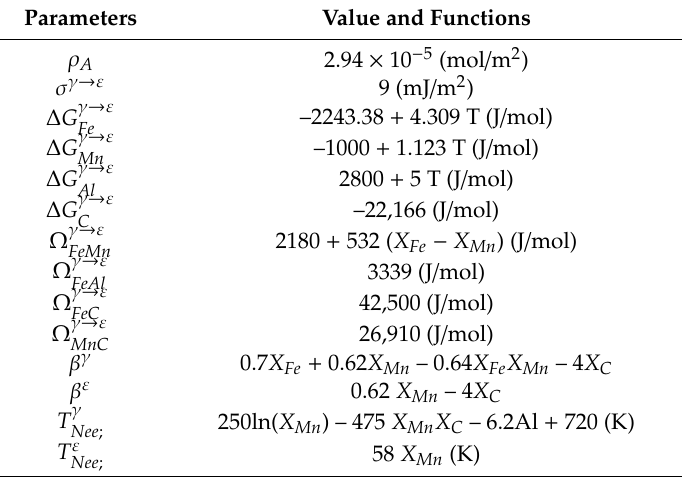
Table 2. The parameters used in the calculation of the SFE.